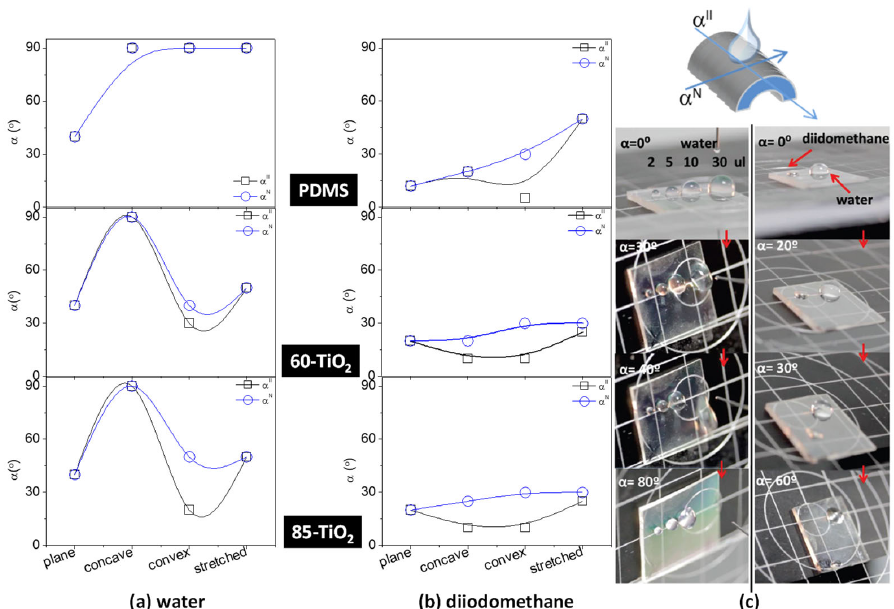
Figure 3. ( a , b ) Sliding angles ( α II parallel and α N perpendicular to the direction of ordered micro ‐ grooves, respectively) vs. type of strain configuration for PDMS and 60° ‐ and 85° ‐ TiO 2 /PDMS samples. The volumes of the water and diiodomethane droplets were 30 μ l and 5 μ l, respectively. ( c ) Images showing the sliding behavior of 2, 5, 10 and 30 μ l water drops left on a 60° ‐ TiO 2 /PDMS sample at increasing tilting angles (left), and images of a 10 μ l water and 5 μ l diiodomethane drops left on the 85° ‐ TiO 2 /PDMS sample at increasing tilting angles (right).